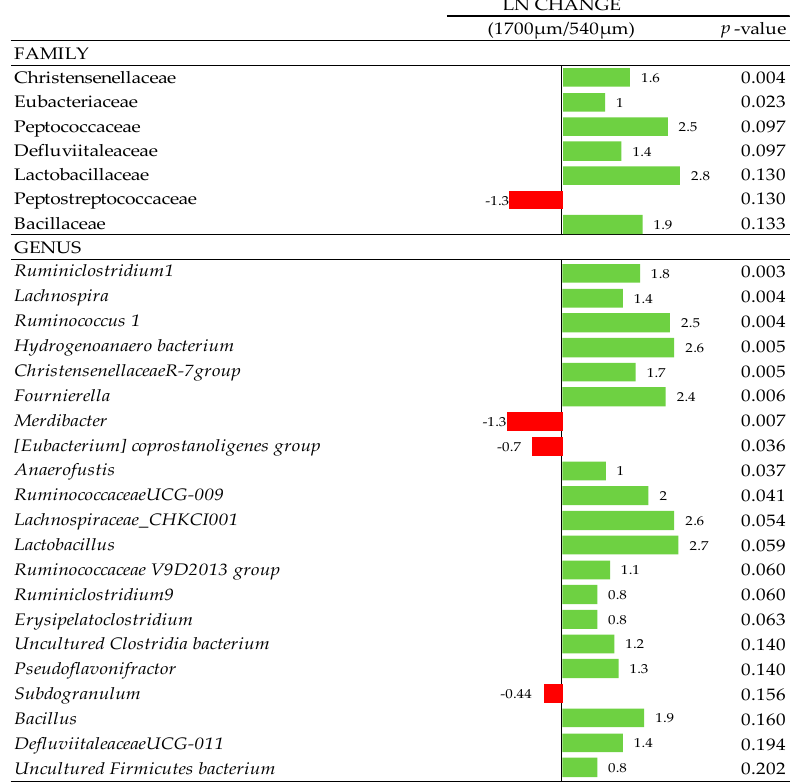
Figure 6. Ln changes promoted by the particle size (1700 and 540, µm) of D gw corn diet (fold discovery rate p- adjusted < 0.20) in taxa. Positive values (  ) and negative values (  ) indicate greater and lower abundance. Taxa are sorted by level of significance (from higher to lower). Differences presented are based on all taxa detected in samples per